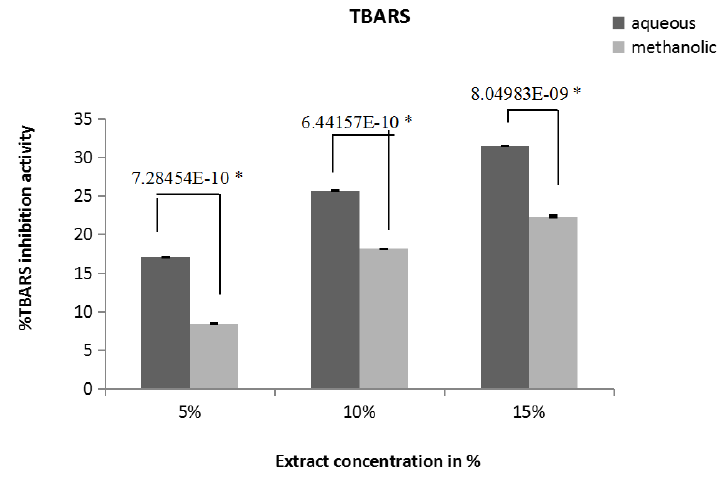
Figure 3. Inhibition of lipid peroxidation. Inhibition of lipid peroxidation measured in terms of TBARS (thiobarbituric acid reactive substances) in oxidatively damaged goat liver mitochondria by different concentrations of aqueous and methanolic extracts of A. catechu (5%, 10%, 15%). * Statistically significant ( p ≤ 0.05).